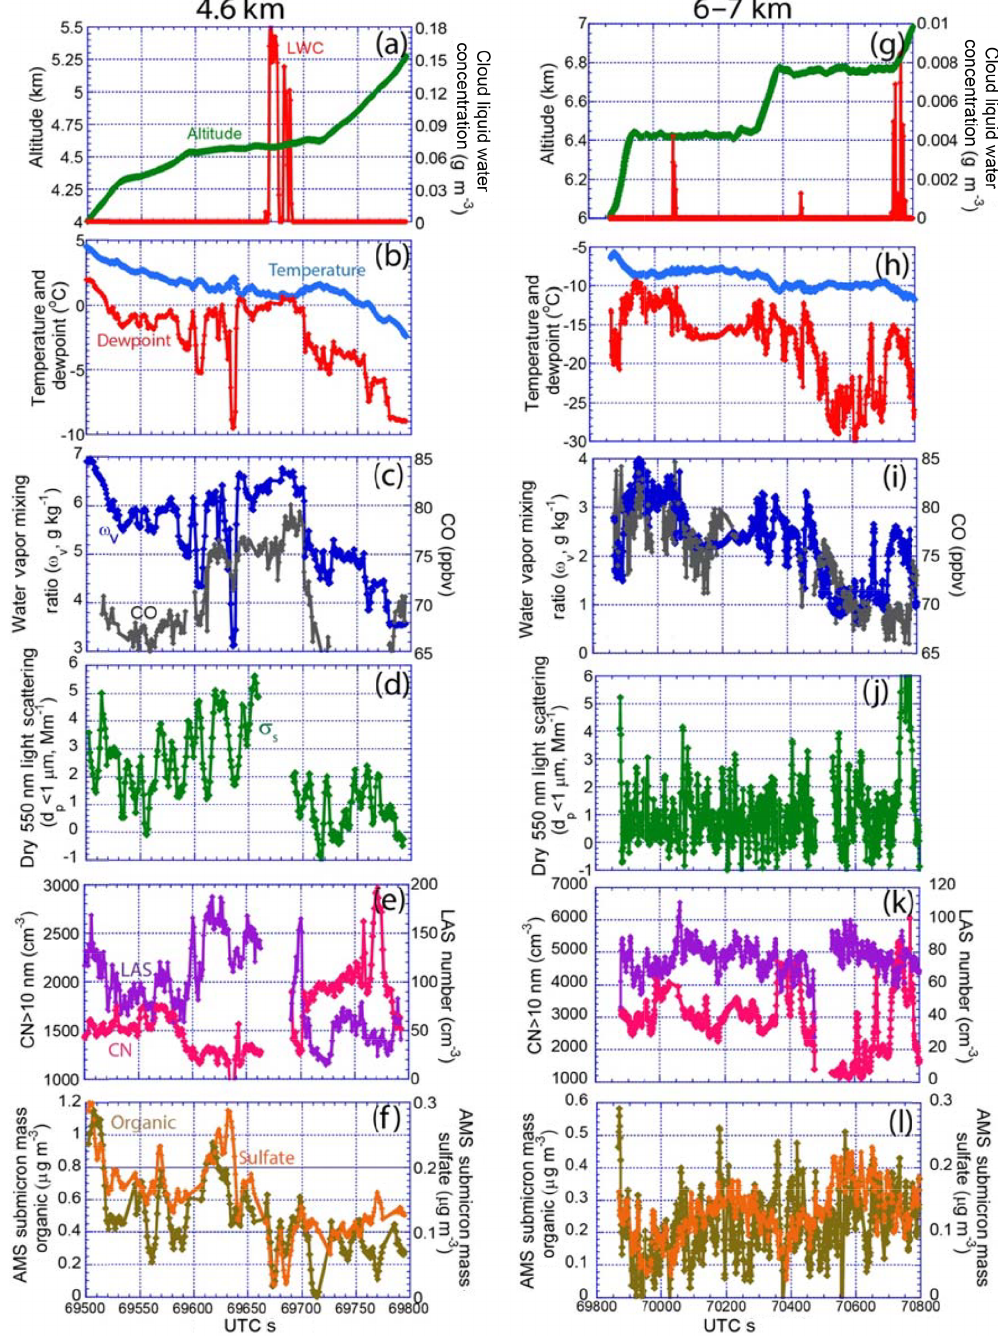
Figure 7. Time series of key meteorology, cloud and aerosol properties entering a detrainment shelf cloud on 12 August 2014. The legends for the graphs on the left are the same for graphs on the